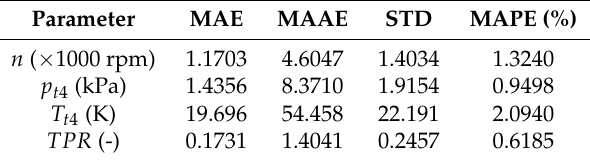
Figure 6. Time series of relative errors for system state variables and TPR. Table 3. Error terms of different engine